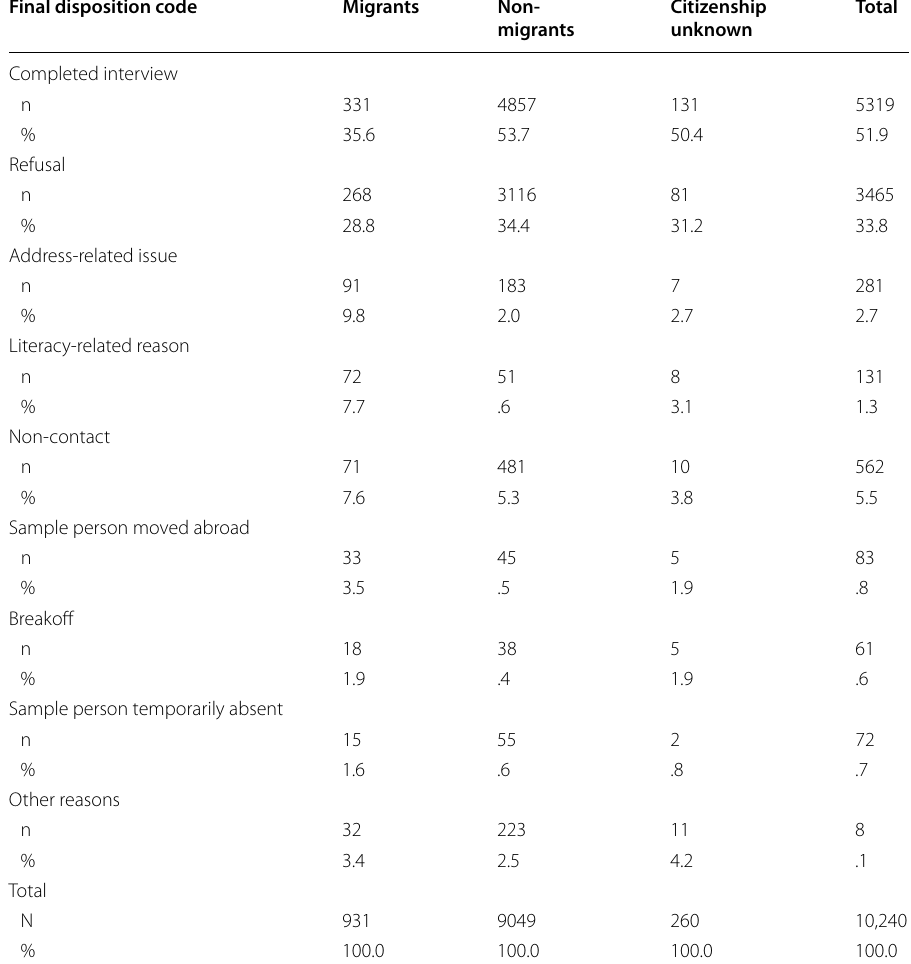
Sorted by most frequently cited reasons by